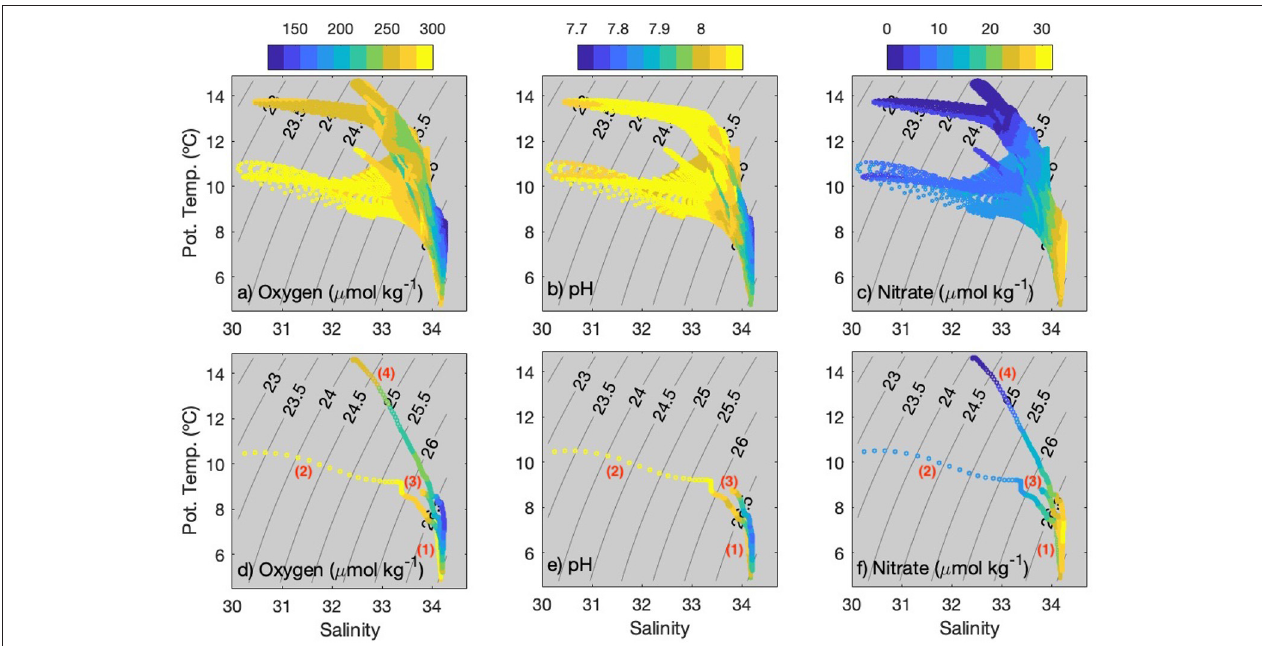
FIGURE 4 | T-S diagrams with values of (a,d) oxygen, (b,e) pH, and (c,f) Nitrate in color. All data are included in top panels, whereas selected dates with contrasting freshwater conditions are shown in bottom panels—the dates are (1) April 01, 2016, (2) November 01, 2017, (3) July 01, 2018, and (4) February 15,